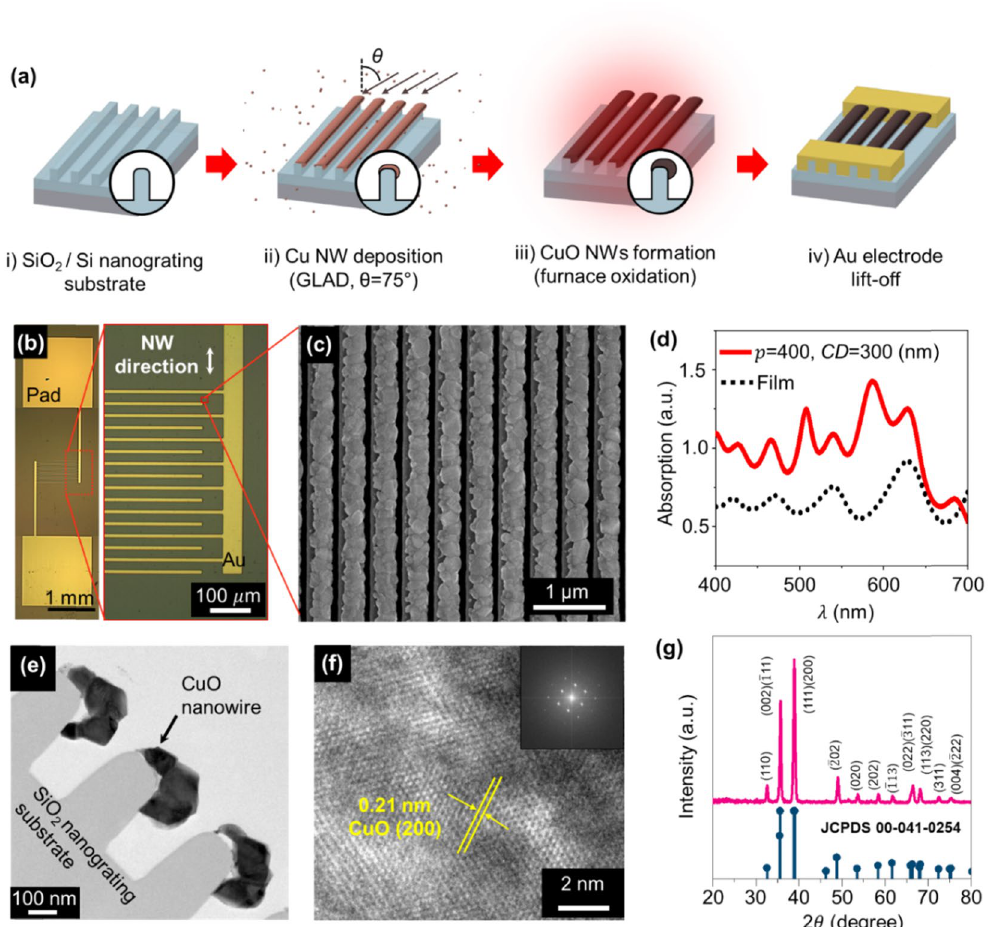
Figure 2. Device demonstration. ( a ) 3D-schematics of the fabrication process. ( b ) Optical image of the fabricated device (left panel). The CuO nanowires are fabricated on the entire area on the substrate. The red dashed box is magnified in the right panel. ( c ) Top SEM image of the fabricated CuO nanowires. ( d ) The measured absorption data of the fabricated CuO nanowires (red solid line) and thin film CuO (black dashed line). ( e ) TEM HR mode of fabricated CuO nanowire (cross-sectional view). ( f ) Magnified TEM image of CuO NW (inset: Fourier transform pattern of single grain of CuO). ( g ) The measured XRD pattern of the fabricated CuO nanowire (upper panel) and reference diffraction lines of the monoclinic tenorite phase of CuO (JCPDS 00-241-0254) (lower